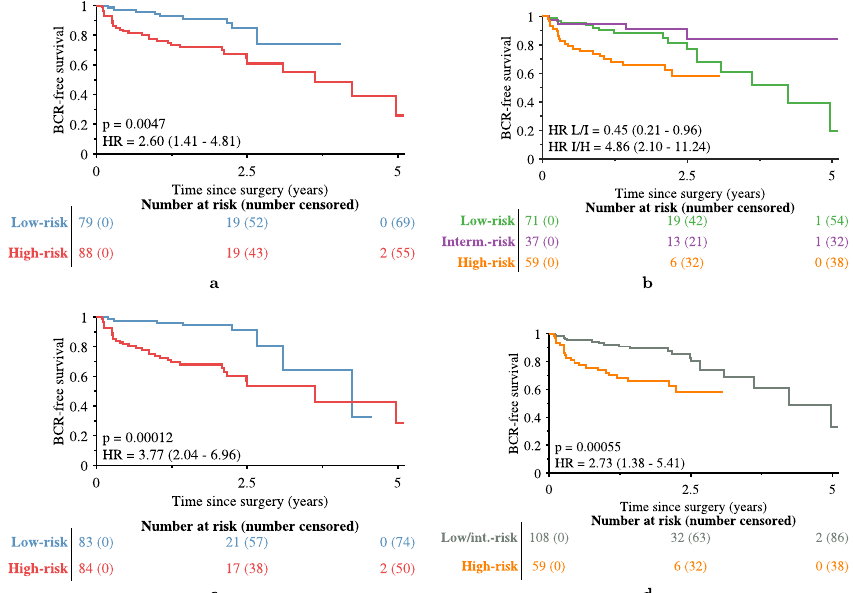
Fig. 5 Kaplan-Meier BCR-free survival plots of the 167 patients of the validation set who had Decipher score information. Patients are strati fi ed by ( a ) Histotyping, ( b ) Decipher risk groups, c Histotyping + , which incorporates Histotyping, pre-operative PSA, and Gleason grade group, and ( d ) Decipher risk groups with low and intermediate-risk as a single